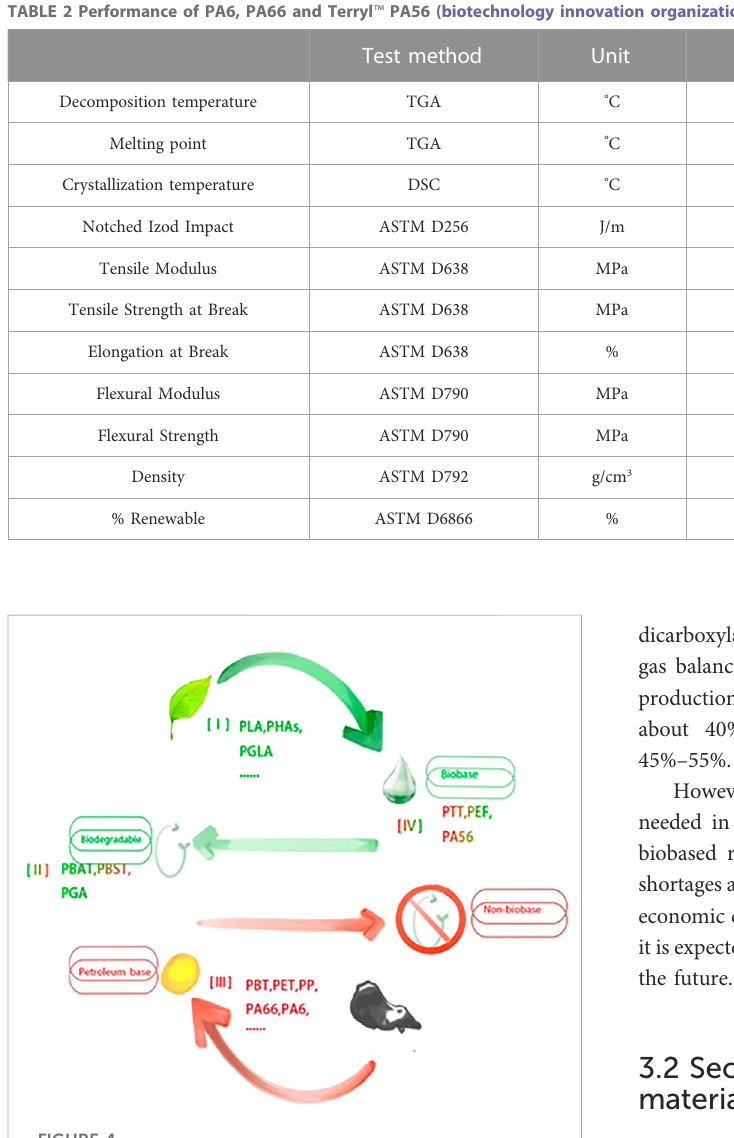
FIGURE 4 Classi fi cation of biobased fi bers and biodegradable fi